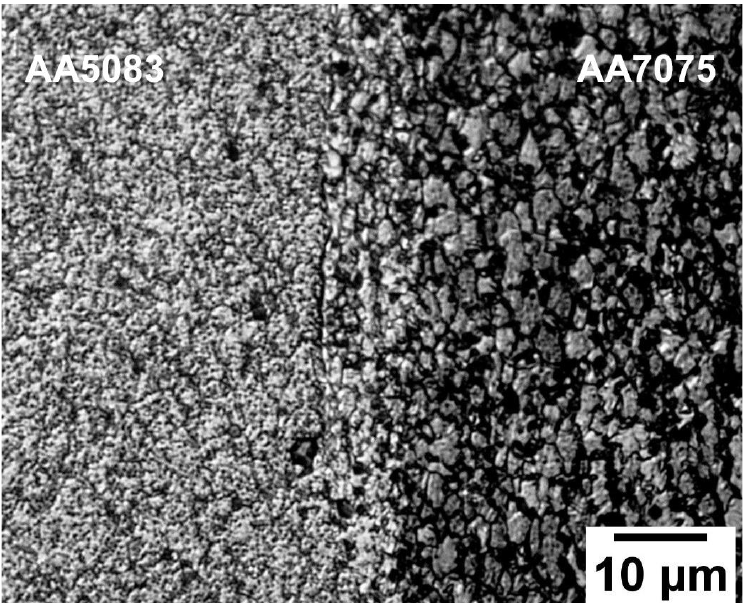
Figure 8. Optical microstructure at the DRZ of AA5083/AA7075-STA welds.